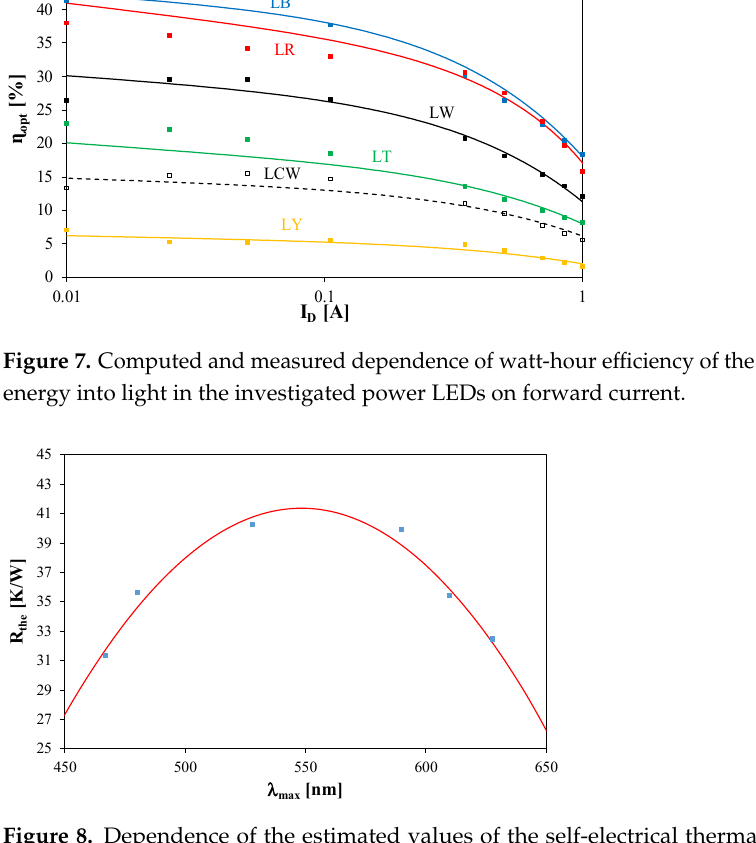
Figure 7. Computed and measured dependence of watt-hour efficiency of the conversion of elec- trical energy into light in the investigated power LEDs on forward current.